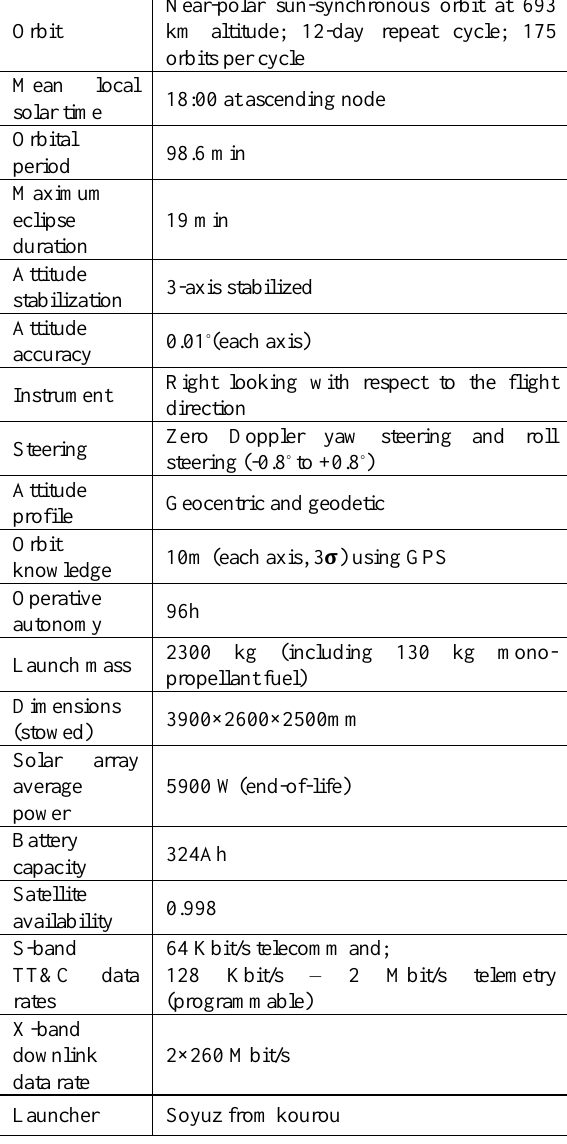
Table 1: Sentinel-1 satellite characteristics (ESA 2017)